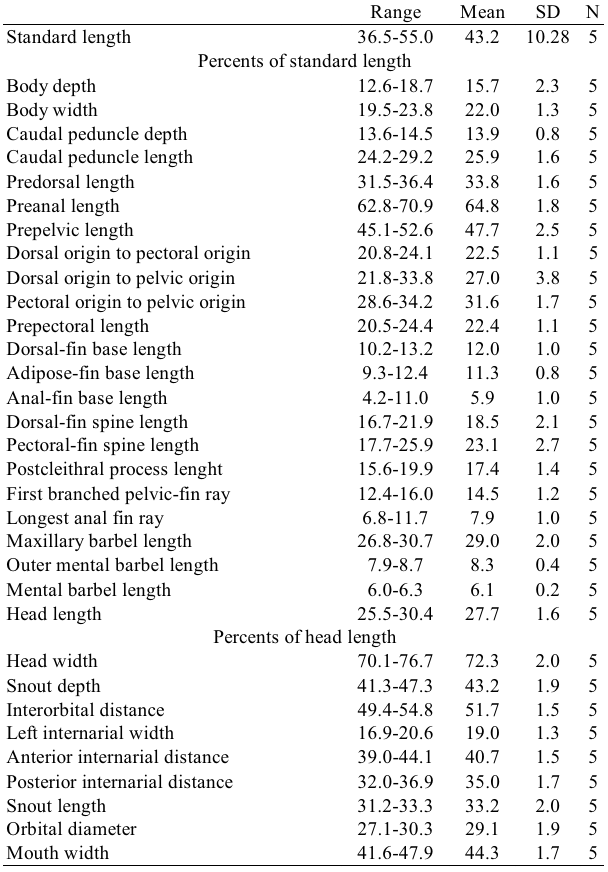
Table 13. Morphometric data for Tatia strigata . SD = stan- dard